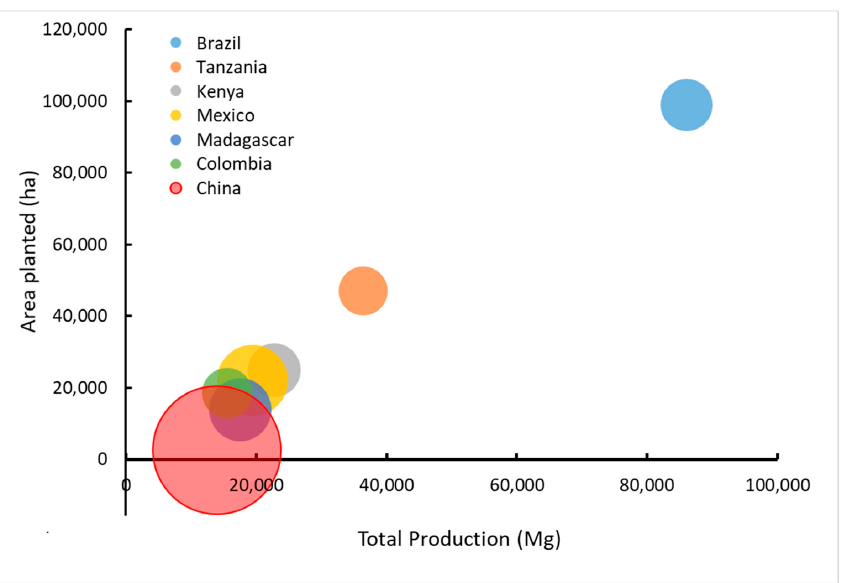
Figure 1. Countries with the greatest production of Agave fiber crops in relation to the amount of area harvested. The size of the circles corresponds to the yield per unit area of crops. Data reflect production in 2020 as reported by FAOSTAT [31].